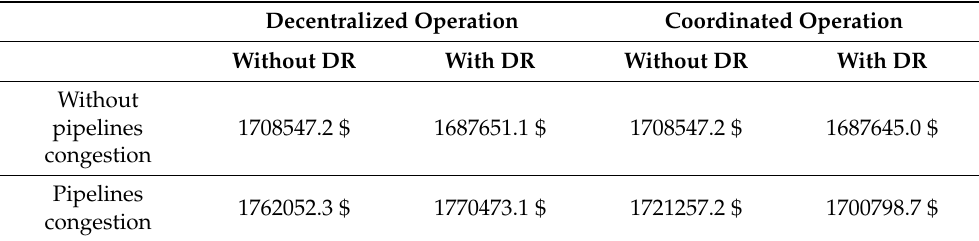
Table 6. The total cost of the electricity